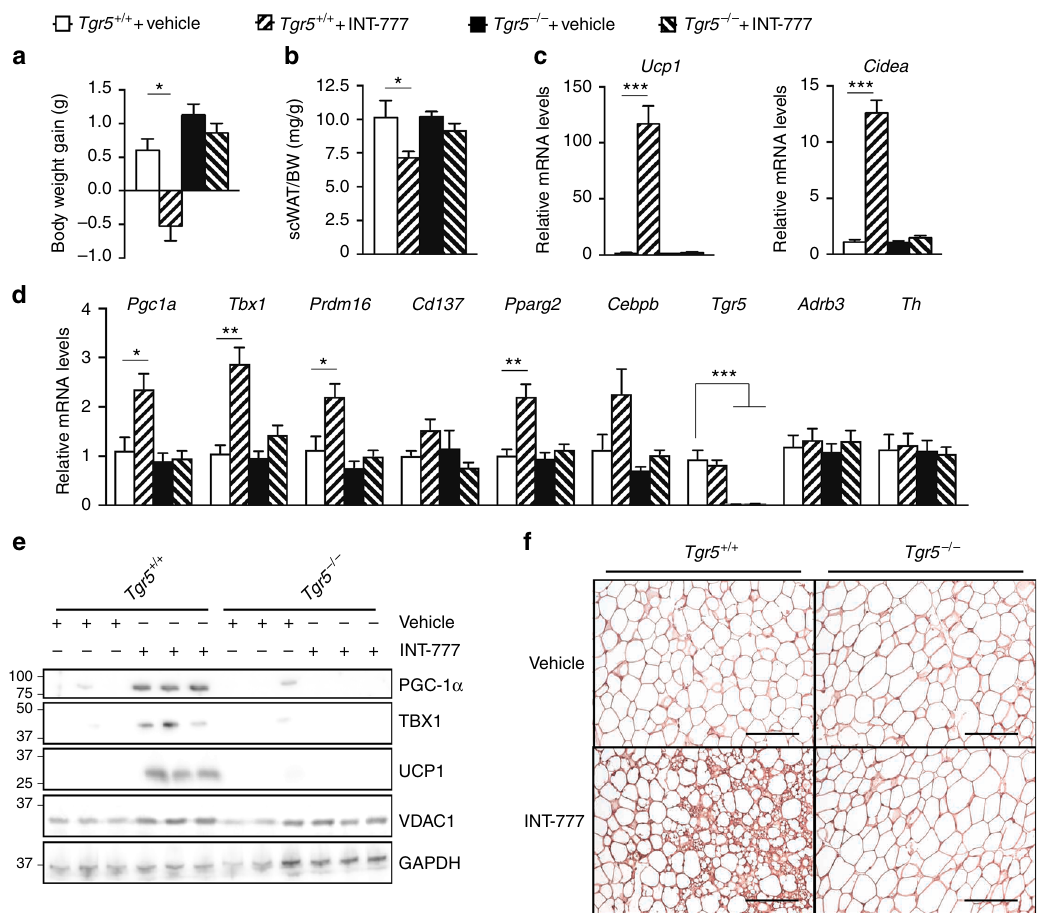
Fig. 3 TGR5 activation induces scWAT beiging at thermoneutrality. a Body weight gain of TGR5 wild-type ( Tgr5 + / + ) and germline TGR5 knockout ( Tgr5 − / − ) mice housed at thermoneutrality (30 °C) and subjected to a daily administration of the selective TGR5 agonist INT-777 or vehicle for 7 days. n = 10 per group. b scWAT over body weight (BW) ratio of the mice described in a . c , d mRNA levels of beige remodelling markers Ucp1 and Cidea ( c ), Pgc1a , Tbx1 , Prdm16 , and Cd137 , Pparg2 and Cebpb ; Tgr5 and adrenergic related genes ( Adrb3 and Th ) ( d ) in the scWAT of mice described in a . e Representative ( n = 10 per group) western blot of PGC-1 α , the mitochondrial marker VDAC1, and beiging markers TBX1 and UCP1 from the scWAT of mice described in a . GAPDH was used as loading control. f Representative ( n = 5 per group) UCP1 immunostaining of scWAT sections from mice described in a . Scale bars = 50 μ m. Results represent mean ± SEM. * P ≤ 0.05, ** P ≤ 0.01 and *** P ≤ 0.001 vs. Tgr5 + / + + Vehicle group by one-way ANOVA followed by Bonferroni post hoc test. Uncropped western blots are provided in Supplementary Fig. 11A –